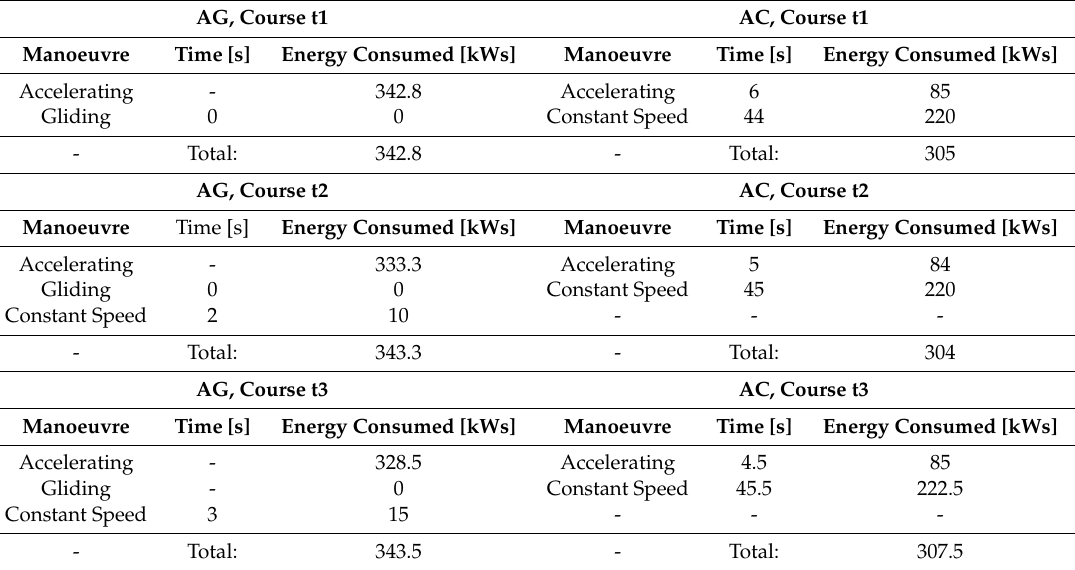
Table 2. Power demand and trip time for a distance of 52